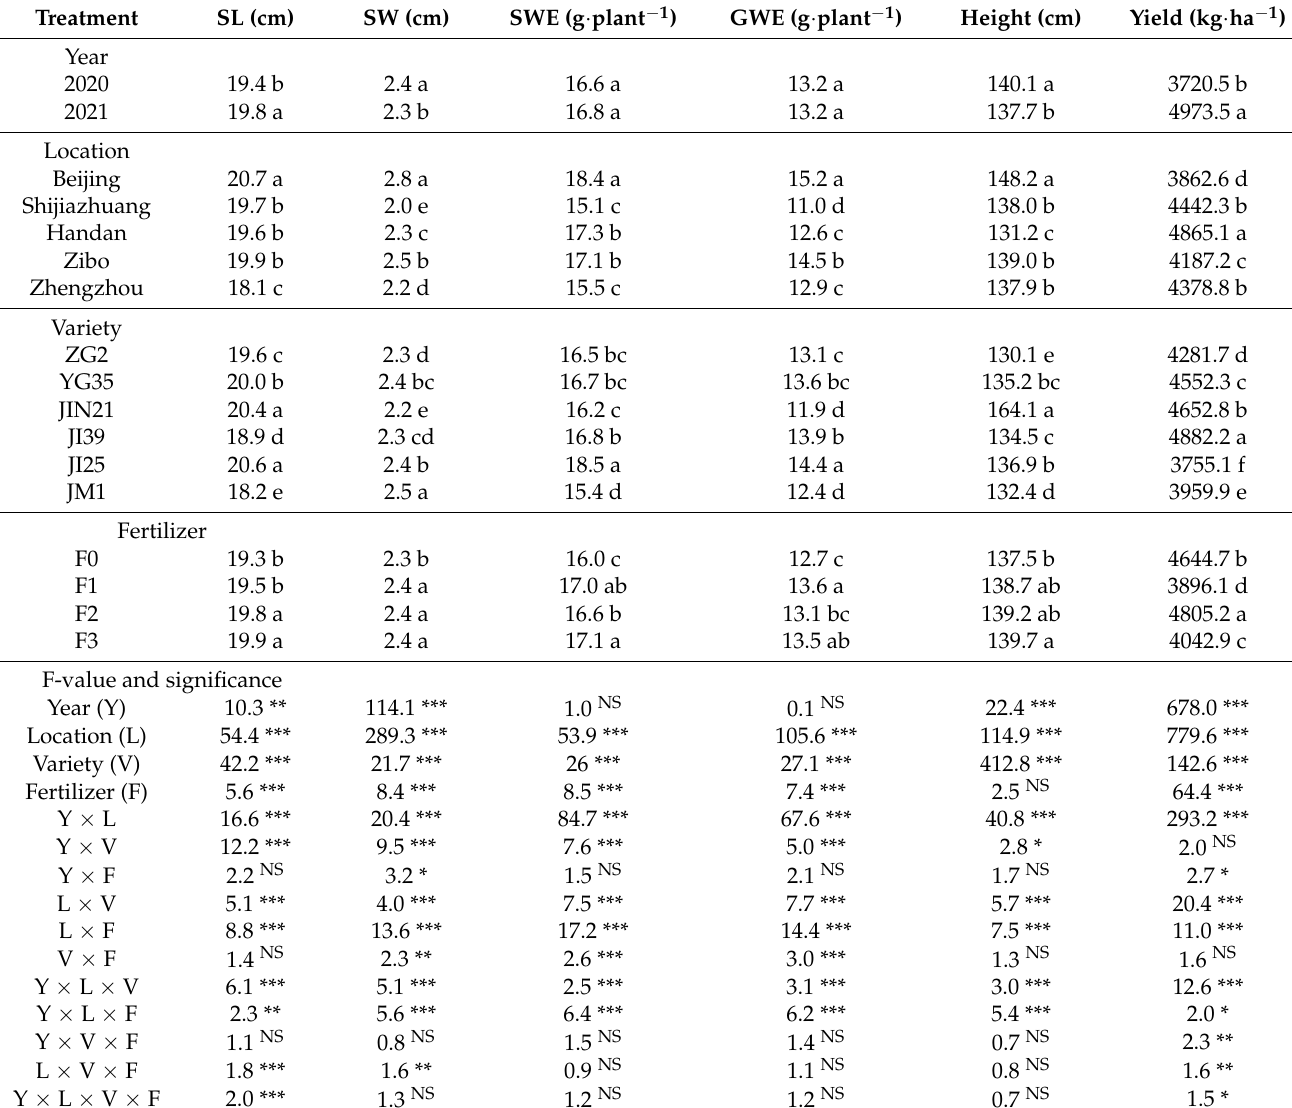
Table 3. Interaction effect of year, location, variety and fertilization on yield traits of foxtail